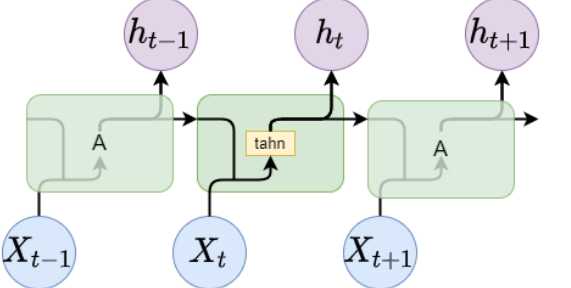
Figure 3. RNN basic architecture [33].